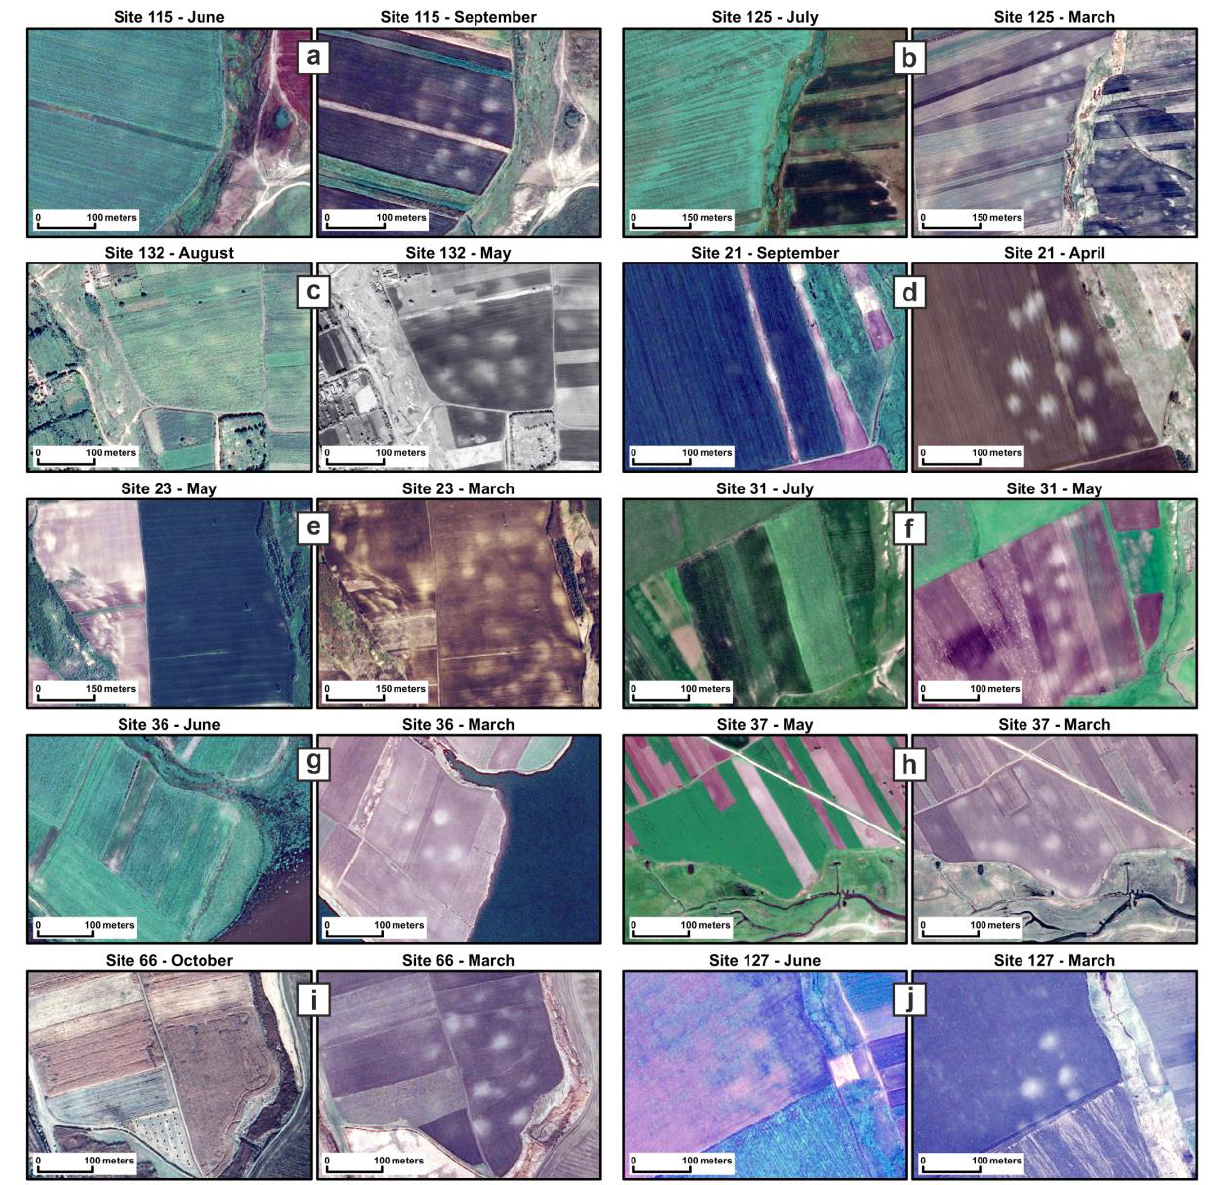
Figure 3. Aerial images (left—during the vegetation season; right—during the spring agro-technical works) with unexcavated LBA sites belonging to Noua Culture in the Jijia catchment: ( a ); Site 115 —Dumești, Holmului Hill; ( b ) Site 125 —Erbiceni, Spinoasei Hill/Valea Lungă; ( c ) Site 132 — Fântânele, Cimitirul Ortodox; ( d ) Site 21 —Aroneanu, Șapte Oameni; ( e ) Site 23 —Dorobanț, La Chișcă; ( f ) Site 31 — Boureni, Popa Mort Hill; ( g ) Site 36 —Valea Oilor, Mădârjești Pond; ( h ) Site 37-Valea Oilor, North of the village; ( i ) Site 66 —Ceplenița, Ion Clacă Hill; ( j ) Site 127 —Spinoasa, Drumul Poștei Hill; the so-called ashmounds (circular gray spots visible on the field) with temporal resolution during the spring agro-technical works (right image of each example).